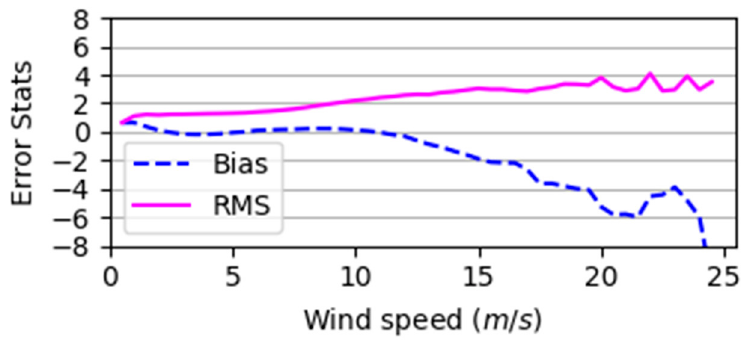
Figure 11. Root Mean Square and bias from CCMP-derived sea surface wind speed in different wind bins.